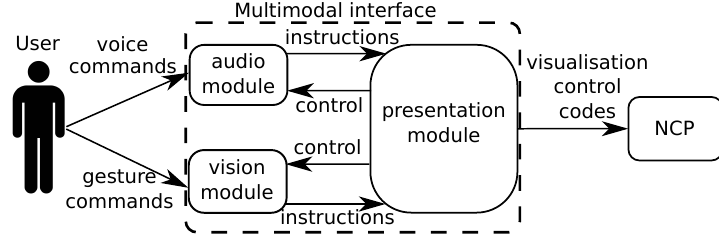
Figure 3. Interactions between interface modules and National Cybersecurity Platform